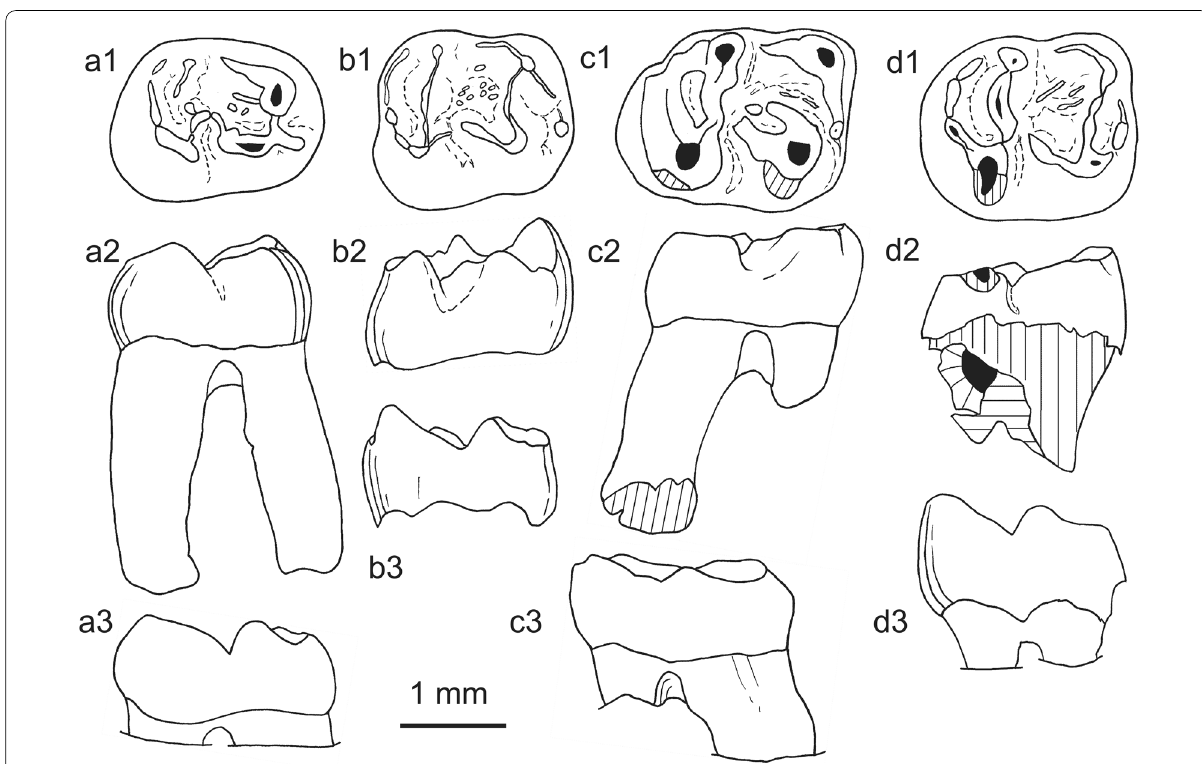
Fig. 11 Lower molars of Protadelomys cartieri (Stehlin & Schaub, 1951), from Lissieu (Rhône), a LIS 41, right p4; a1, occlusal view; a2, buccal aspect; a3, lingual aspect. b LIS 54, right m1; b1, occlusal view; b2, buccal aspect; b3, lingual aspect. c: LIS 33, right m3; c1, occlusal view; c2 buccal aspect; c3, lingual aspect. d LIS 60, right m2; d1, occlusal view; d2, buccal aspect; d3, lingual aspect. Scale bar